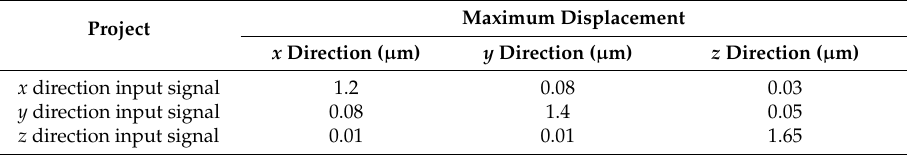
Table 2. Experimental data analysis of linear motion performance.